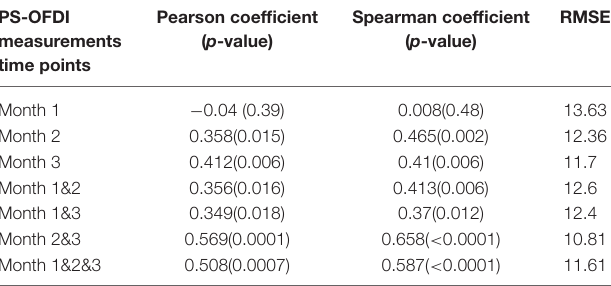
TABLE 2 | Summary of the linear regression model for predicting the scar area 6 months after third-degree burn injury based on early time point measurements with